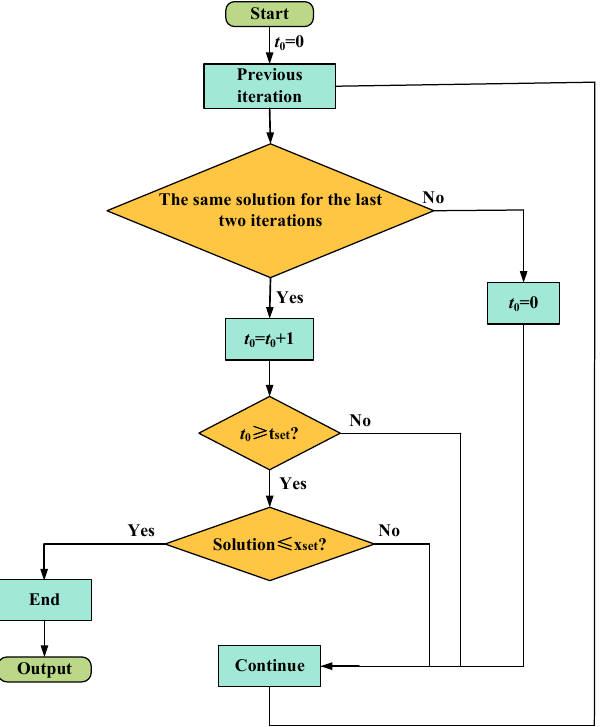
Figure 2. The flowchart of IETS.